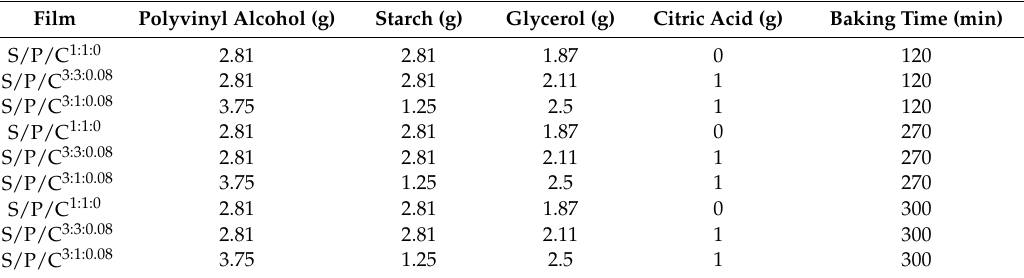
Table 1. Test design of